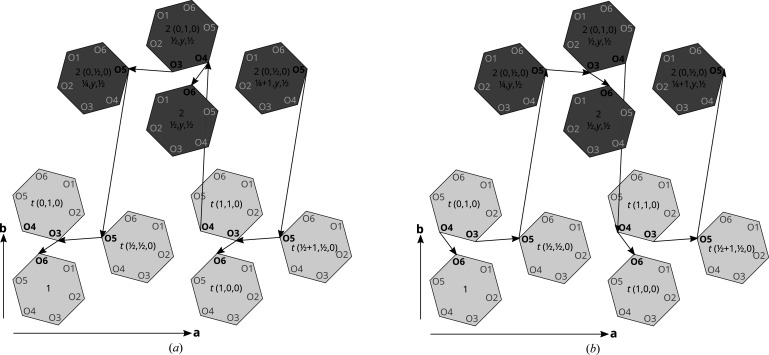
Schemes of infinite chains of 1 molecules connected by hydrogen bonds. Each hexagon represents a molecule. At the center is indicated the operation relating the given molecule to the reference molecule at the bottom left. Light and dark gray hexagons represent molecular orientations related by a 2[010] rotation. Translational symmetry is represented by the position on the graph and is relative to the indicated a and b basis vectors. Arrows represent hydrogen bonds in direction of the arrow (i.e. the acceptor atom is at the end of the arrow).